Question: Sum up the contents of this chart in one sentence.
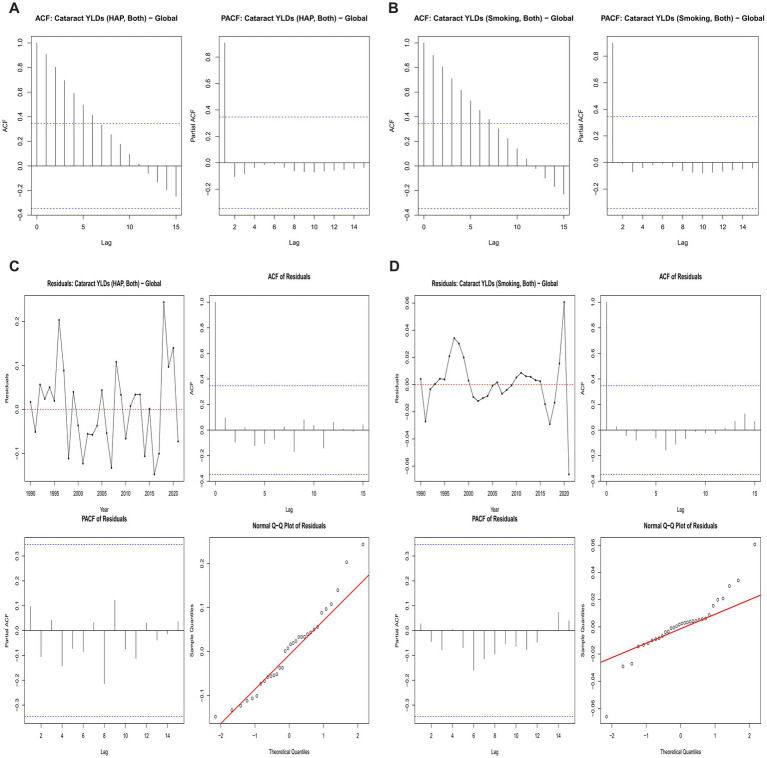
Answer: ACF and PACF plots (A, B) and residual diagnostic panels (C, D) for global ASYR time series of cataract attributable to HAP (A, C) and smoking (B, D) , 1990–2021. All residual lags fall within the 95% confidence bounds (blue dashed lines), confirming white noise distribution and adequate model fitting. Residual diagnostics in panels C and D consist of residual time-series plot, residual ACF, residual PACF, and normal Q – Q plot sequentially. ASYR, age-standardised YLD rate; HAP, household air pollution; ACF, autocorrelation function; PACF, partial autocorrelation function.